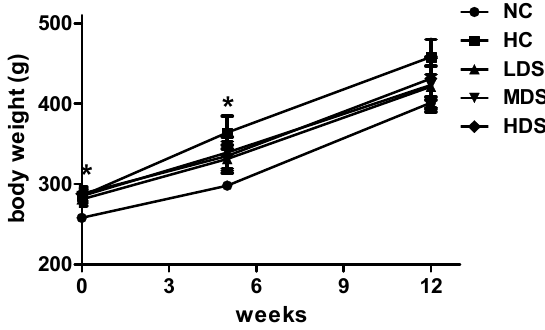
Figure 2. Changes of body weights during the sesamin intervention period. Results are expressed as means ± SEM ( n = 8–10). * p < 0.05 compared with the NC group.